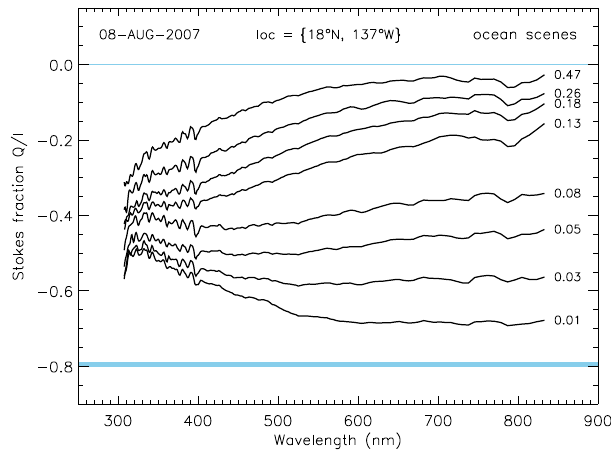
Figure 8. Stokes fraction Q/I as a function of wavelength for ocean Fig. 8. Stokes fraction Q/I as a function of wavelength for ocean scenes with various scenes with various degrees of cloud contamination but otherwise degrees of cloud contamination but otherwise comparable conditions. The numbers indicate comparable conditions. The numbers indicate effective cloud frac- effective cloud fractions. The blue horizontal lines are explained in the text. tions. The blue horizontal lines are explained in the 28